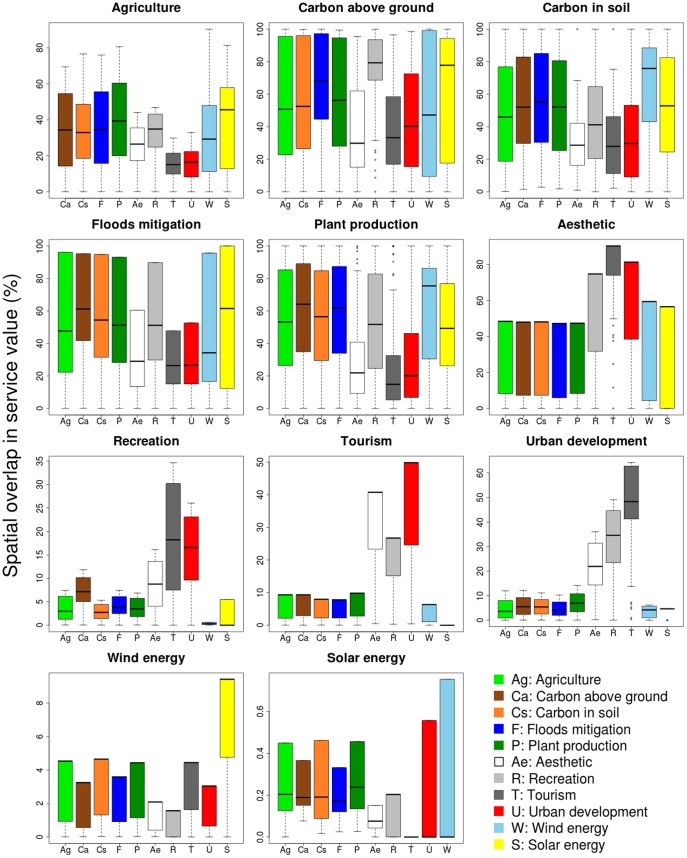
Co-occurrence of environmental services.In each panel is quantified the spatial overlap between a main service and its co-occurring services. The y-axis represents the percentage spatial overlap of the overall co-occurring service value available within the main service: maximum distribution area (top segments or bullet outliers of whisker histograms); the area excluding the lower quartile valued cells (top edge of coloured histogram), the area from the median to the top valued cells (black horizontal lines); the higher quartile cells valued areas (lower edge of coloured histograms), and the area available within the maximum value grid cells (lowest segments or bottom outliers of histograms). Outliers and maximum values are not visible when overlapping with quartile upper boundary.